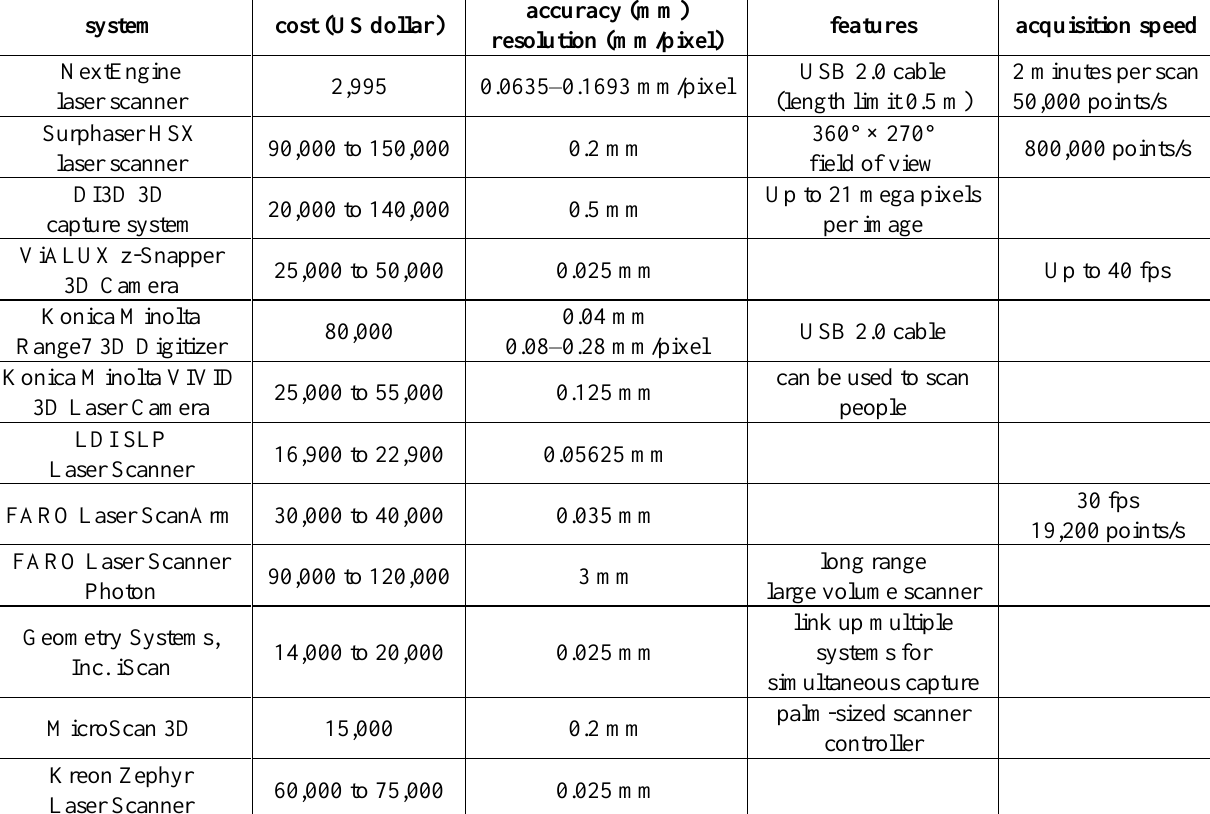
Table 2. Costs and features of different laser range